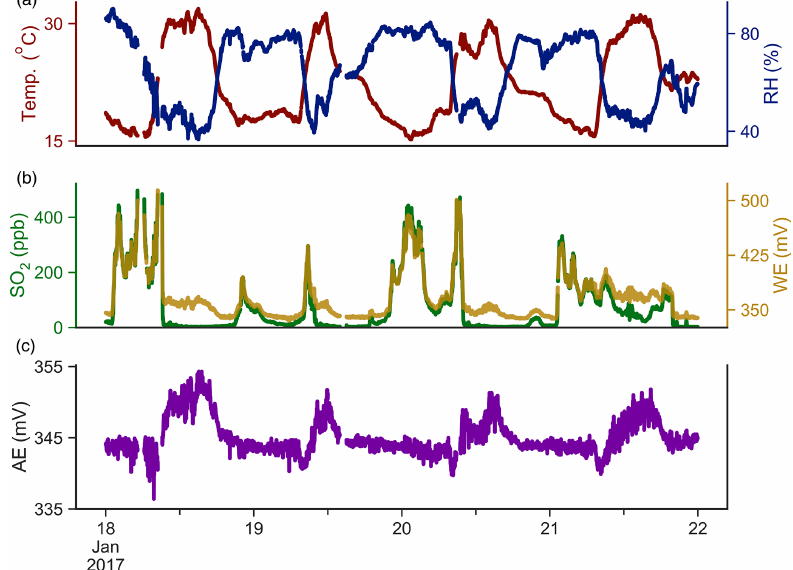
Figure 3. Time series of raw 1min reference SO 2 and Alphasense SO2-B4 data for a 4-day period at the beginning of the field campaign at the Hawaii Department of Health AQ station in Pahala. (a) T and RH exhibit a strong inverse correlation in this environment. (b) Working electrode voltage ( V WE , yellow) and reference SO 2 mixing ratios (green) correlate strongly. (Data above 500ppb were excluded to enable a simple visual comparison.) (c) Auxiliary voltage ( V AE ), which increases when T is high, and V WE and SO 2